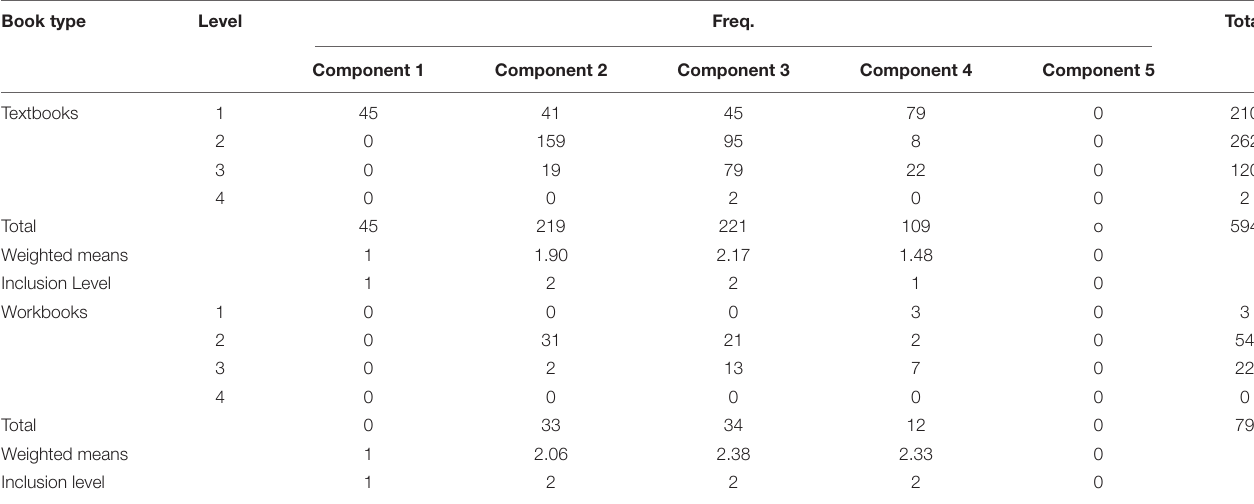
TABLE 3 | Frequencies and percentages of inclusion of each level of discourse components in both students’ textbooks and the workbooks for the 12th-grade mathematics textbooks and